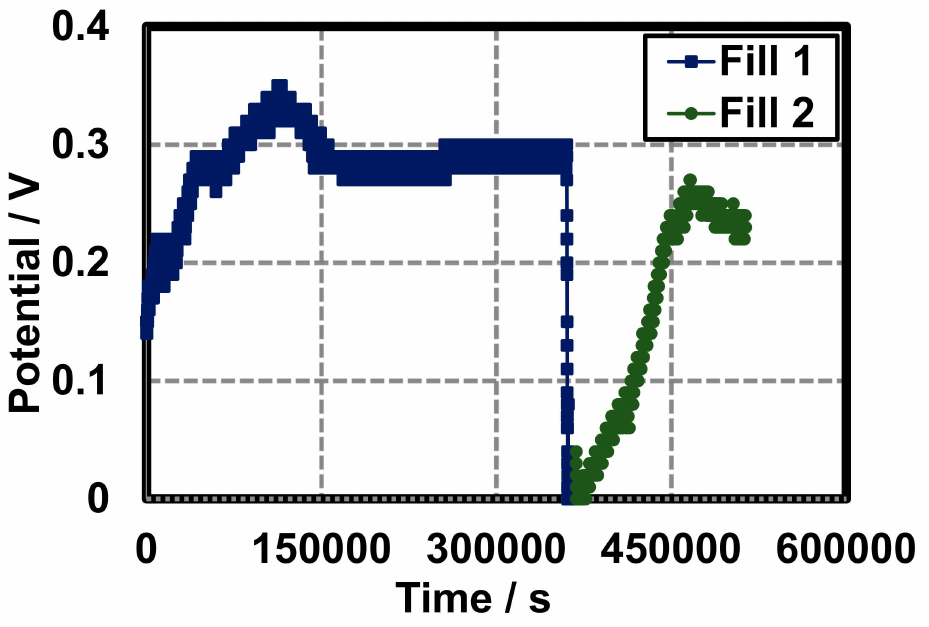
Figure 11. Fill and purge voltage of a closed gel Leclanch é cell under 10 k Ω load with AB conductive additive. The cell was purged and refilled at 400,000